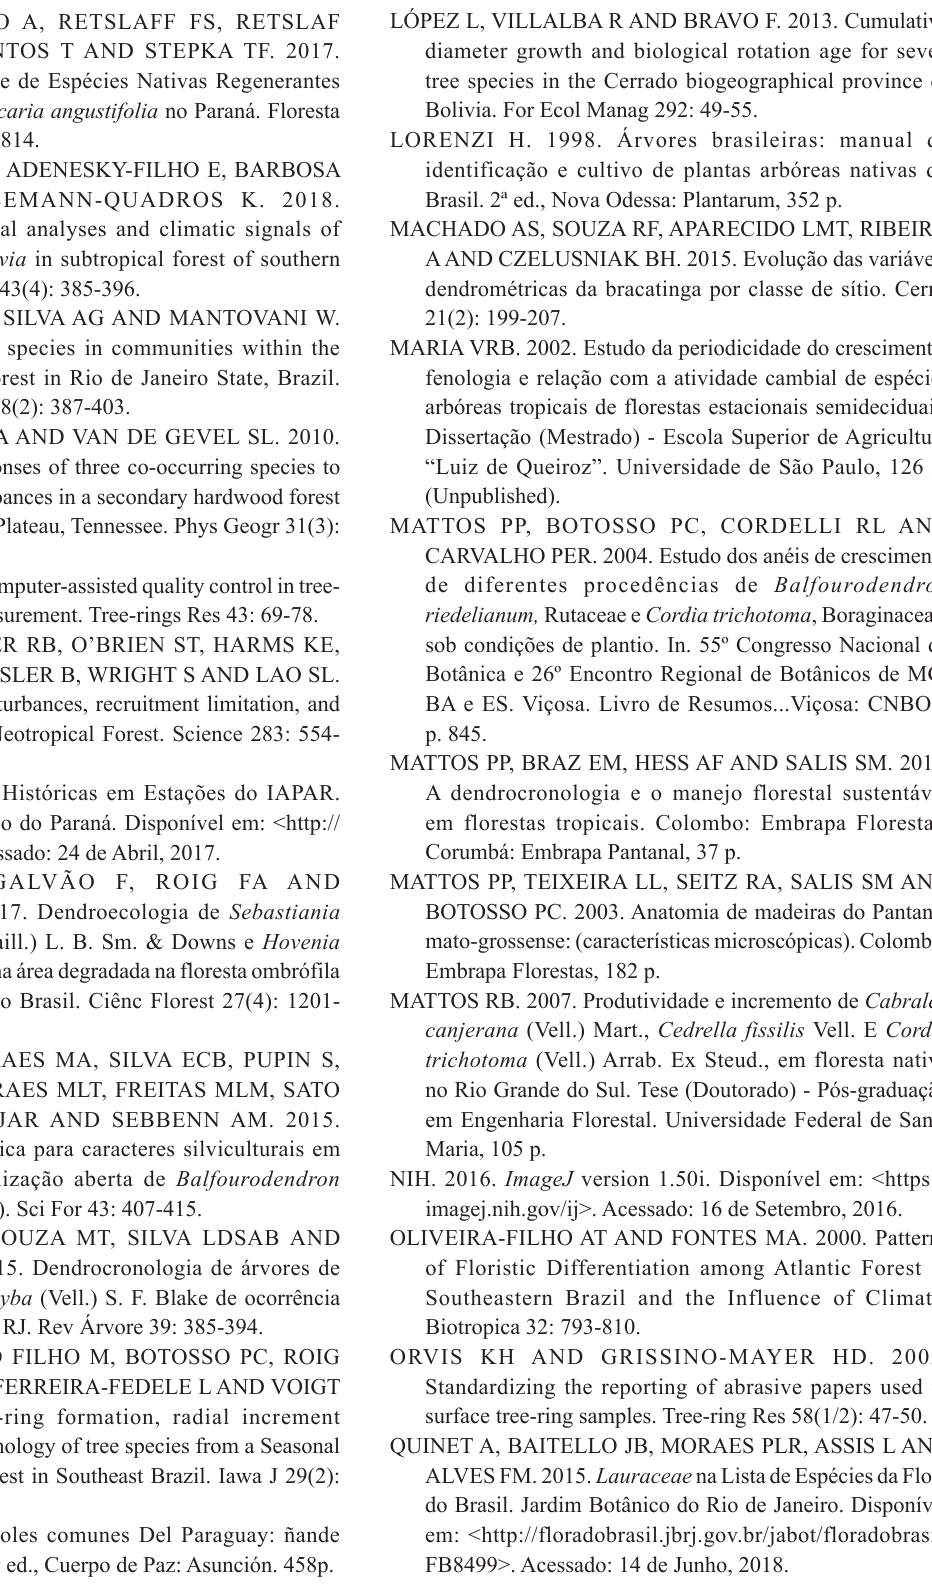
FIgUeIreDO FILHO A, reTSLAFF FS, reTSLAF FS, LONgHI-SANTOS T AND STePKA TF.